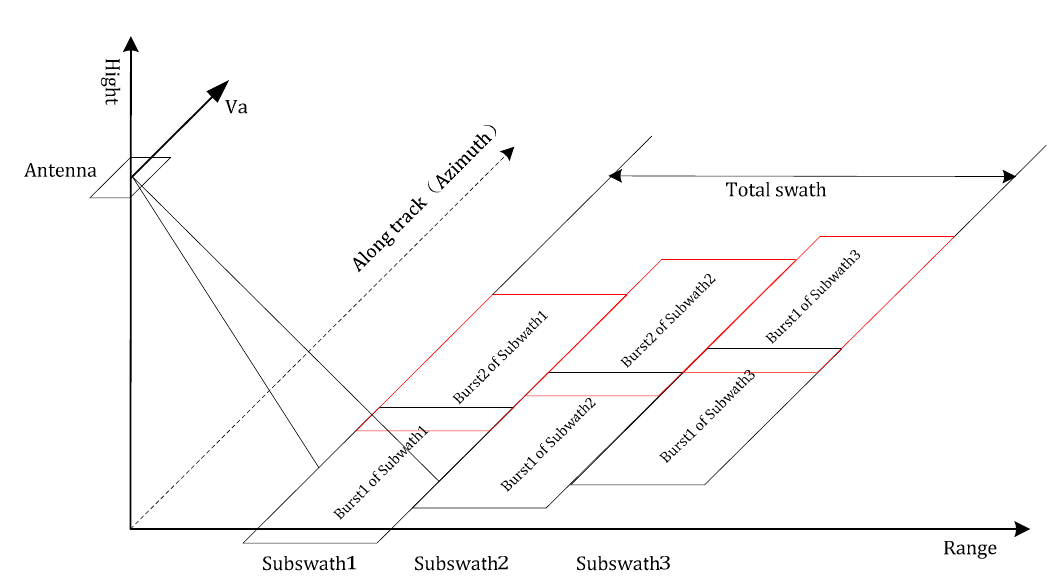
Figure 1. Narrow scanning (NSC) mode working diagram.